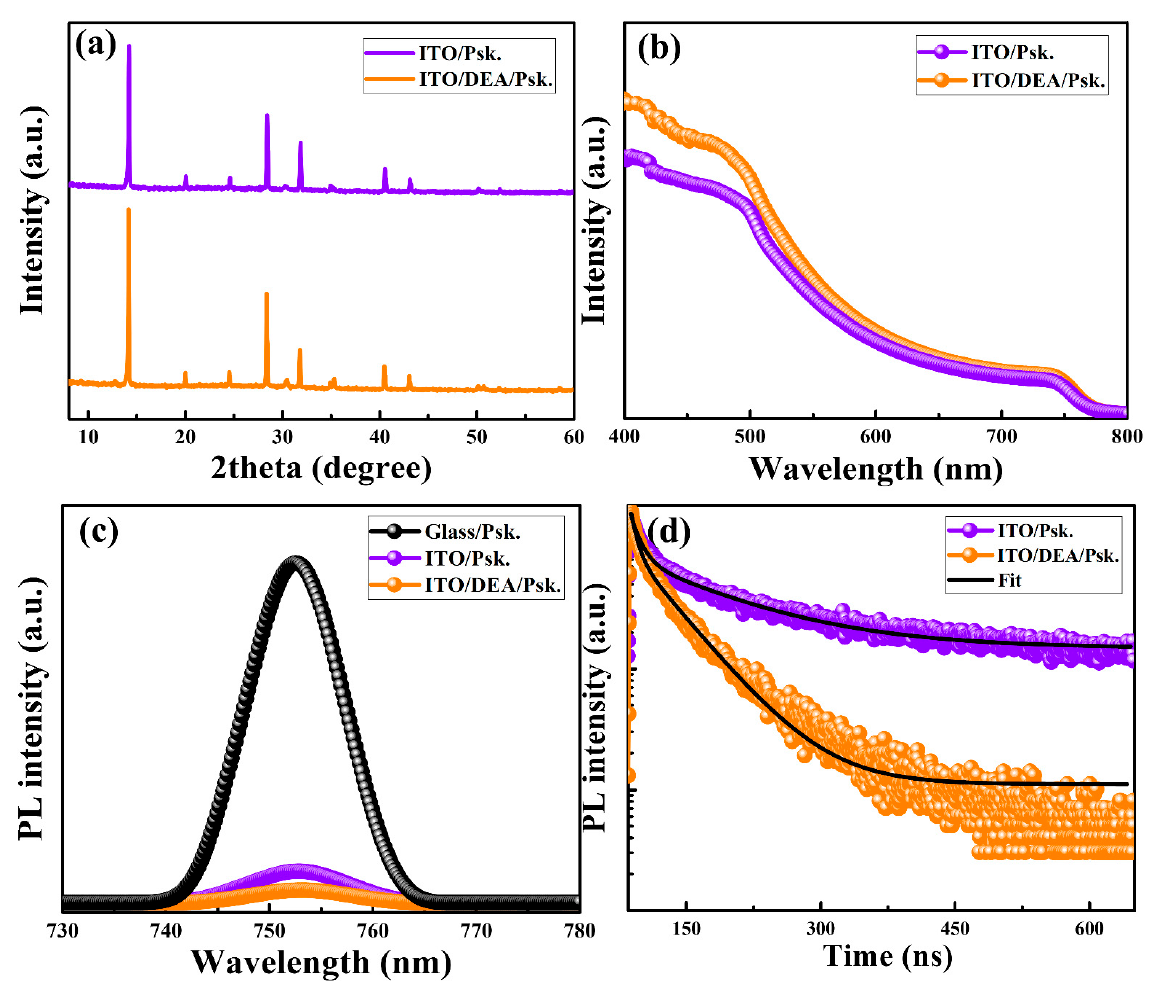
Figure 5. XRD patterns ( a ), UV-Vis spectra ( b ), PL-spectra ( c ), and TRPL-spectra ( d ) of the ITO/perovskite and ITO/DEA/perovskite, respectively.